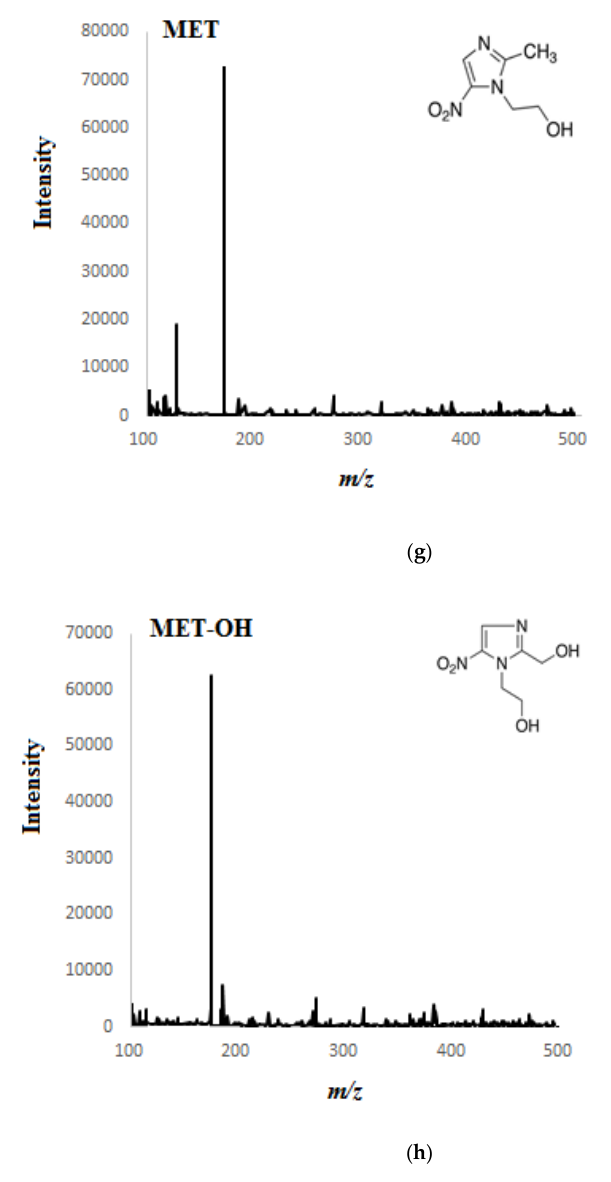
Figure 10. MS spectra for the human plasma samples analyzed after the oral administration of AMOX ( a ), CEF ( d ) and MET ( g ), showing drugs and their metabolites (AMD ( b ), AMA ( c ), CEF-dAceLac ( e ), CEF-dAce ( f ), MET-OH ( h )). In the real samples from patients treated with metronidazole, the presence of one metabolite of the parent drug—hydroxymetronidazole, m/z = 188 (for MET-OH)—was observed. For amoxicillin and cefotaxime, four metabolies were identified at m/z = 366 and 384 (for AMD and AMA, respectively) and at m/z = 396 (for CEF-dAce and CEF-dAceLac). The acquired MS/MS spectra proved that the precursor ion for MET at m/z = 172 was mainly fragmented to m/z = 128 (–C 2 H 4 O) and for MET–OH at m/z = 188 to m/z = 144 (–C 2 H 2 NO) and m/z = 126 (–C 2 H 4 O). For CEF and CEF-DAC-LAC, the precursor ion was at m/z = 456 and m/z = 396, respectively. The CEF fragmentation (MS/MS) created mainly two product ions identified at m/z = 342 and m/z = 396 (major product) and CEF-DAC-LAC fragmented to m/z = 282 and m/z =